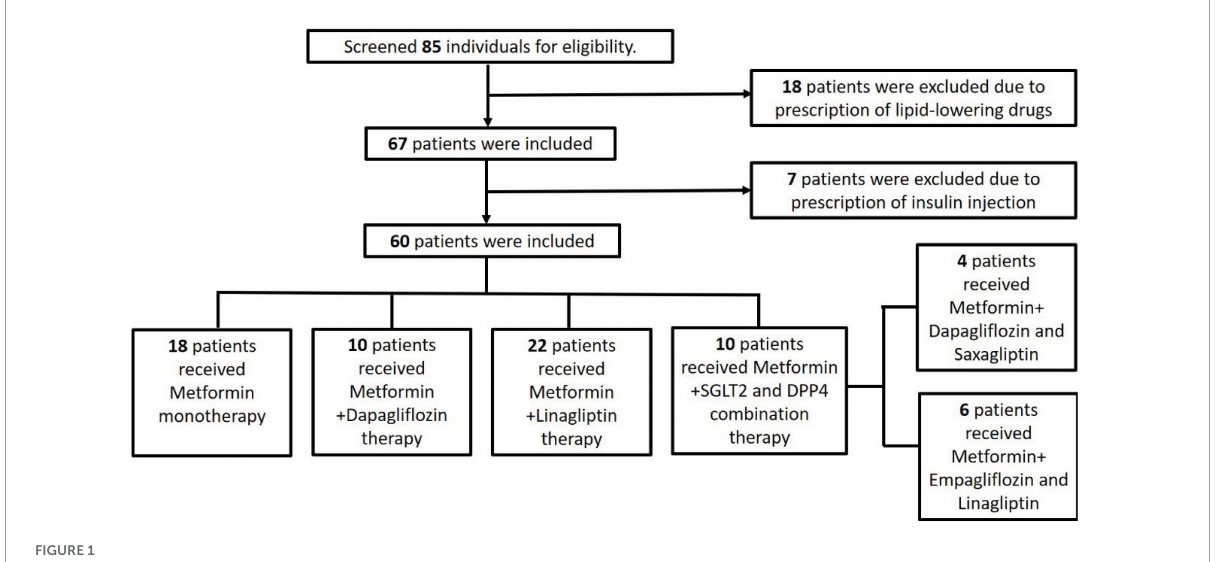
FIGURE1 Flowchart showing patient inclusion in the